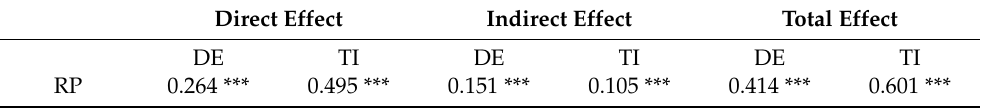
Table 6. Direct effect, indirect effect, and total